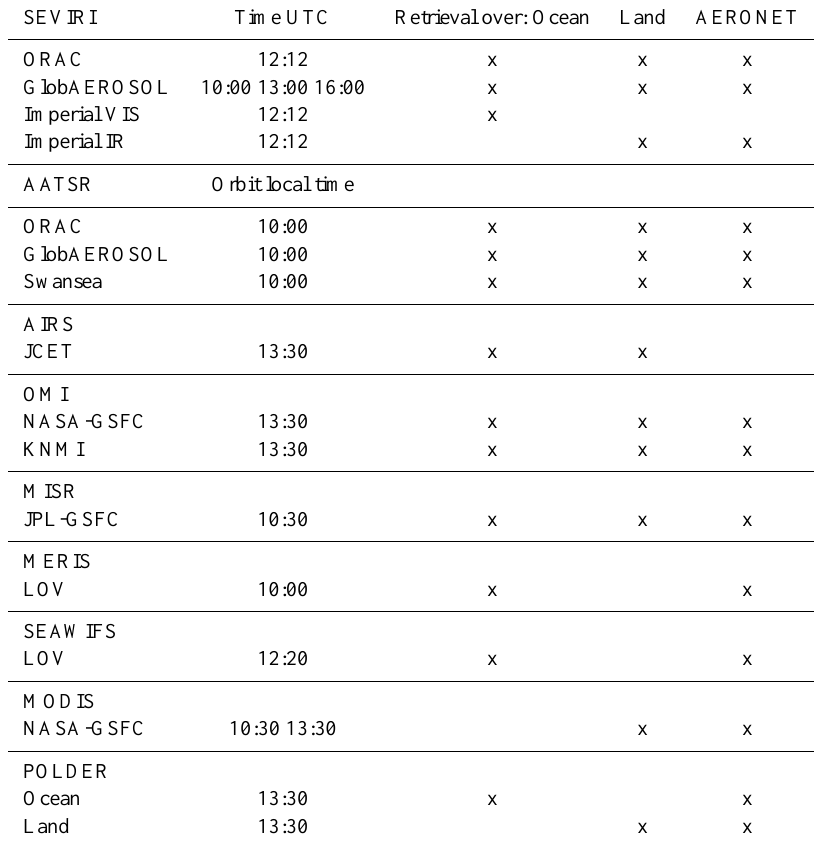
Table 1. List of the different datasets participating in the intercomparison, divided by instrument. The datasets are flagged with a cross for retrieval over land, over ocean and in comparison with AERONET sites. SEVIRI Time UTC Retrieval over: Ocean